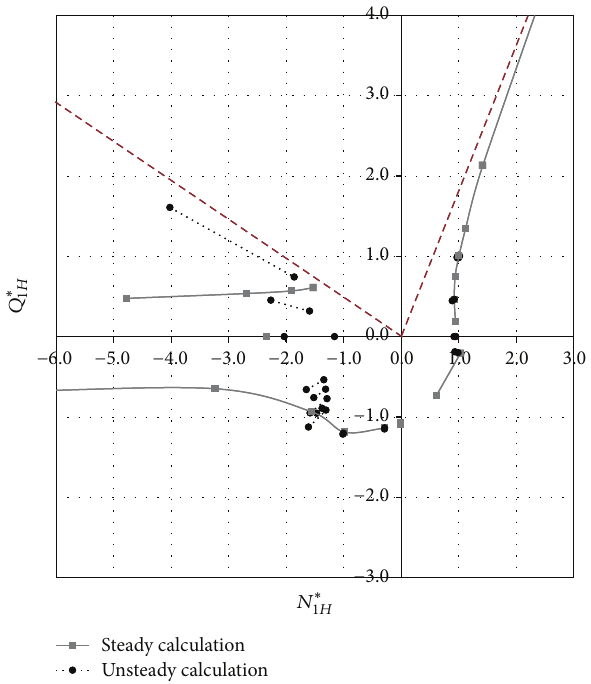
Figure 9: Numerical results obtained with steady state calculations and unsteady